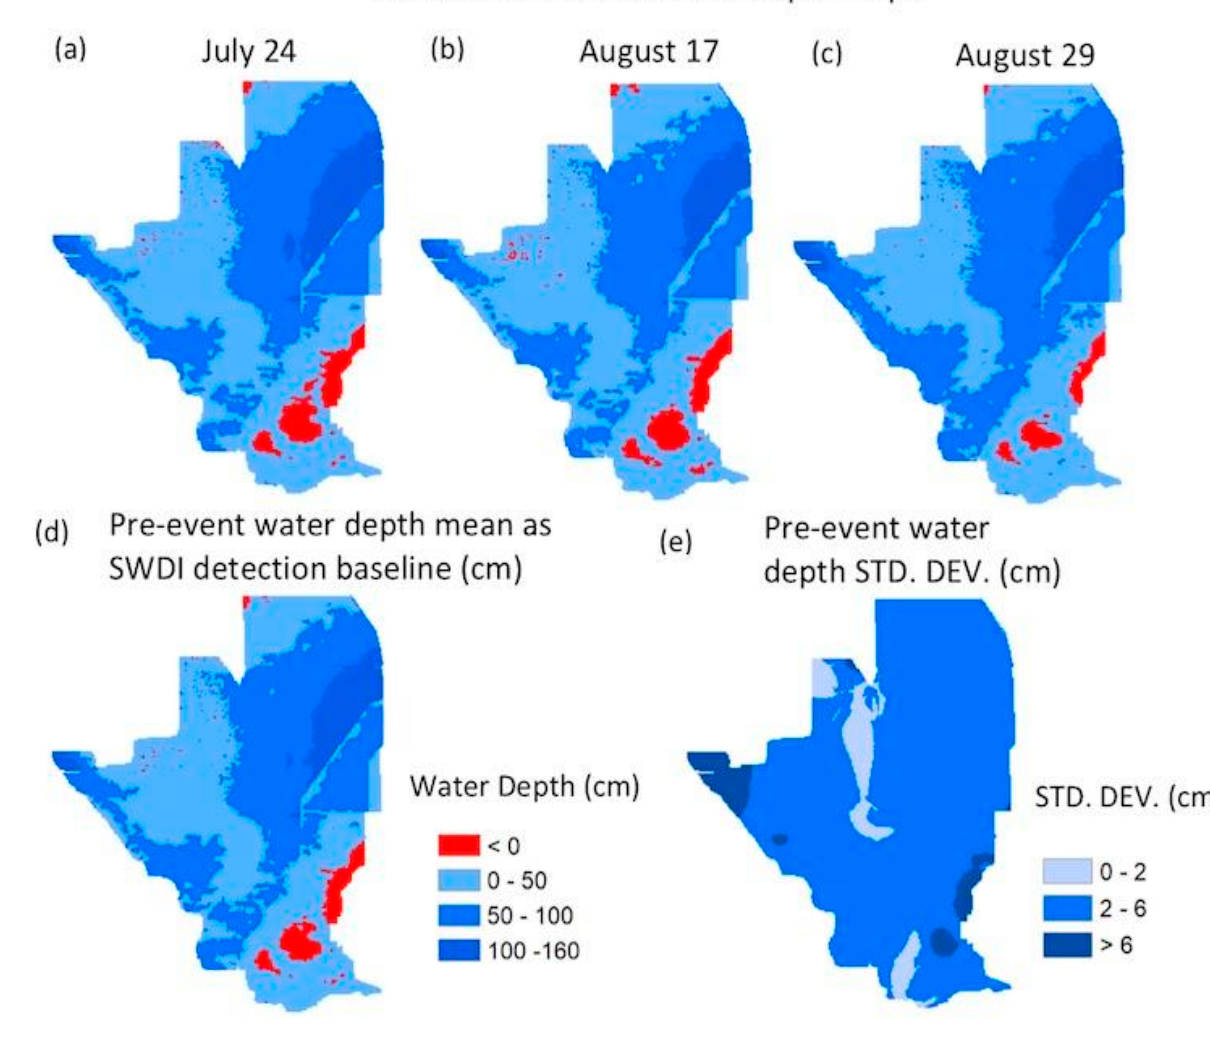
Figure 5. ( a – c ) Pre-event water-depth maps for the three selected SAR dates in 2017. Negative water depths (red areas) represent unflooded conditions, and positive water depths (blue areas) represent flooded conditions. ( d ) Pre-event water-depth mean map as the baseline for SWDI detection. ( e ) Pre- event water-depth standard deviation map, with each pixel representing the standard deviation of three water-depth values for the pre-event SAR dates. Most study areas show standard deviations between 2 and 6 cm, and the spatial mean value of standard deviations is 4 cm.